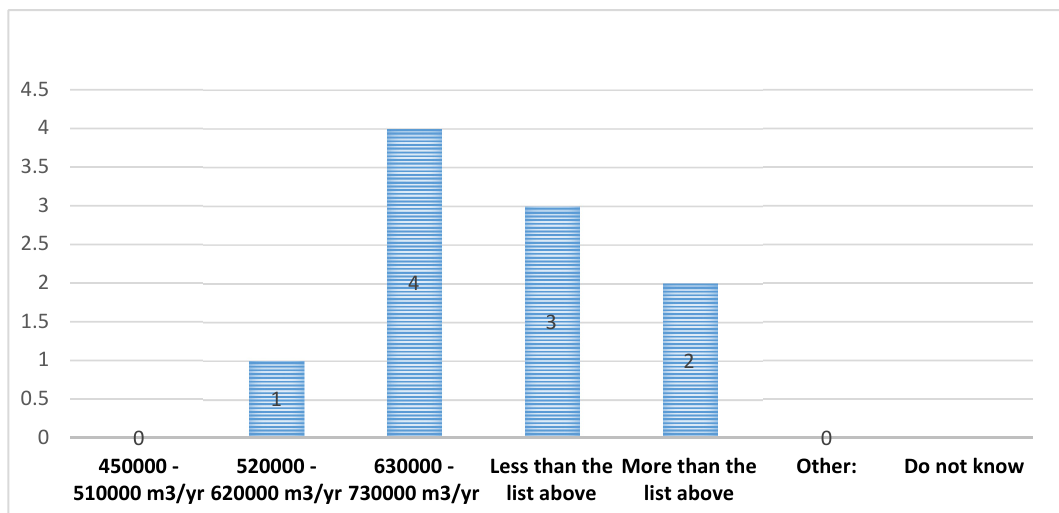
Figure 2. The total volume of timber produced per year.